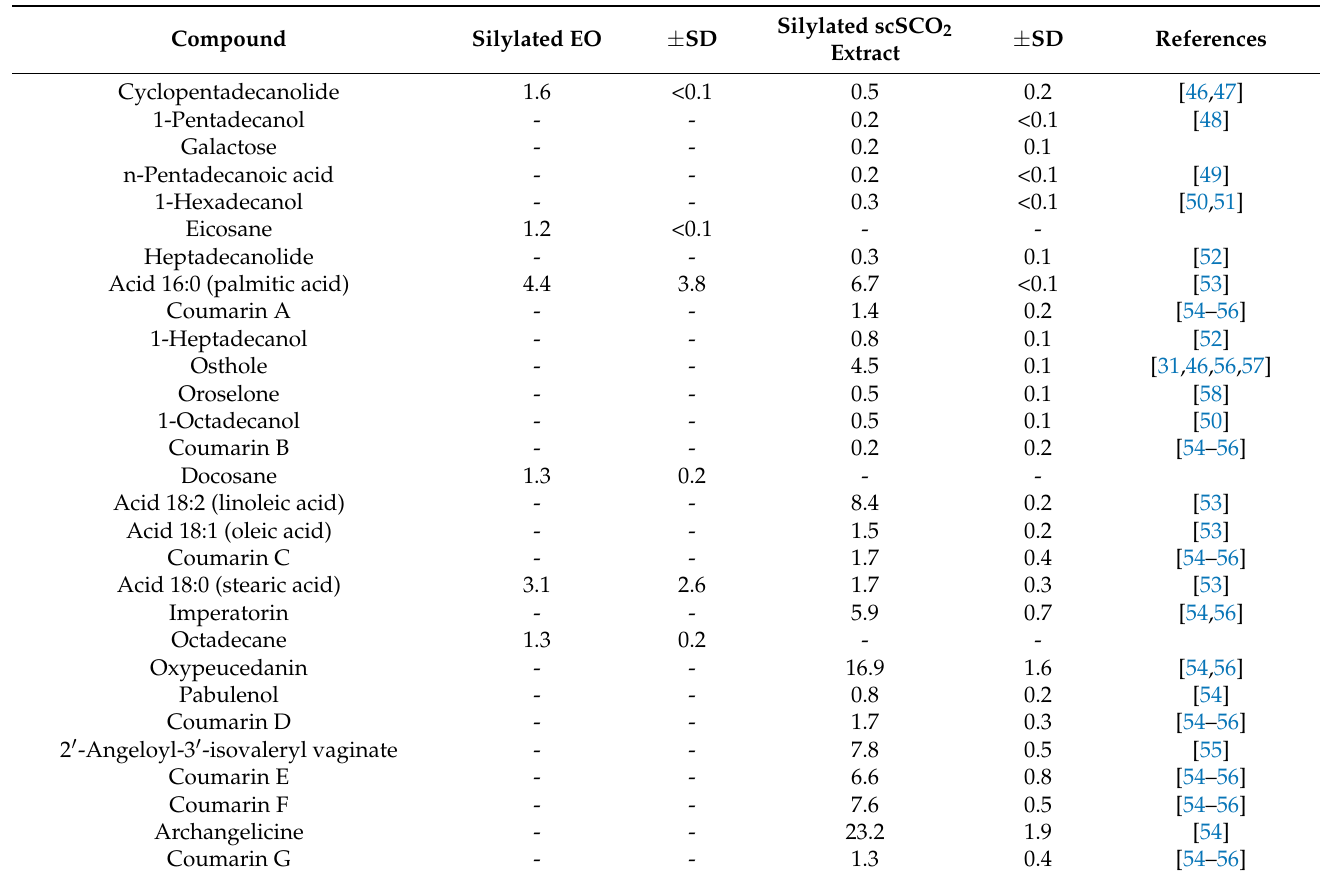
Table 6. The chemical composition (mg/g) of the silylated Angelica root EO ( 1 ) and scCO 2 extract ( 4